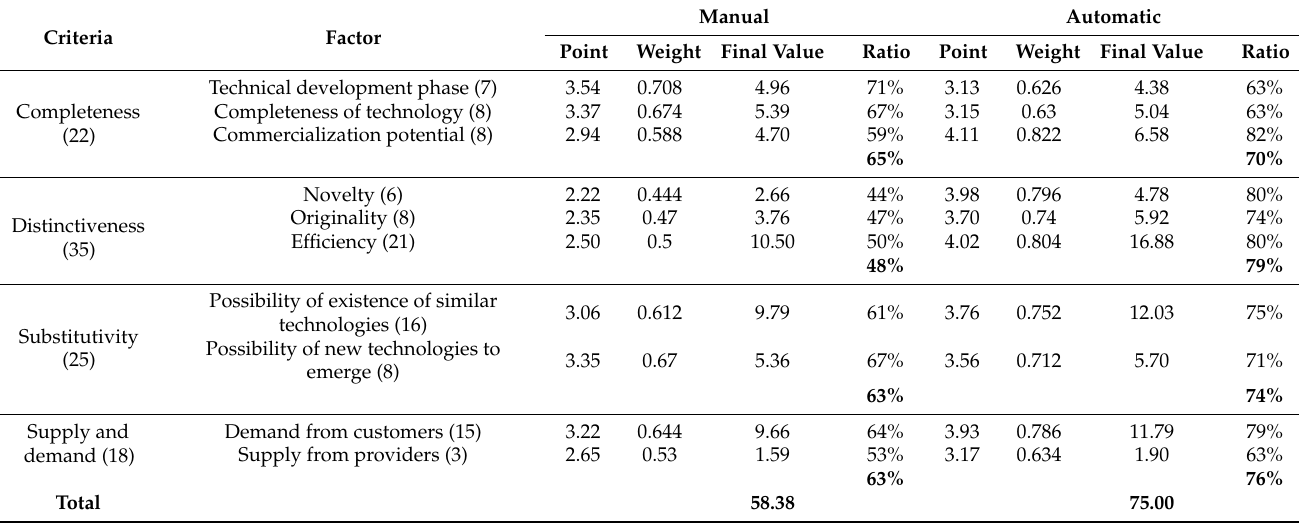
Table 8. Technology value of manual and automatic floor plan